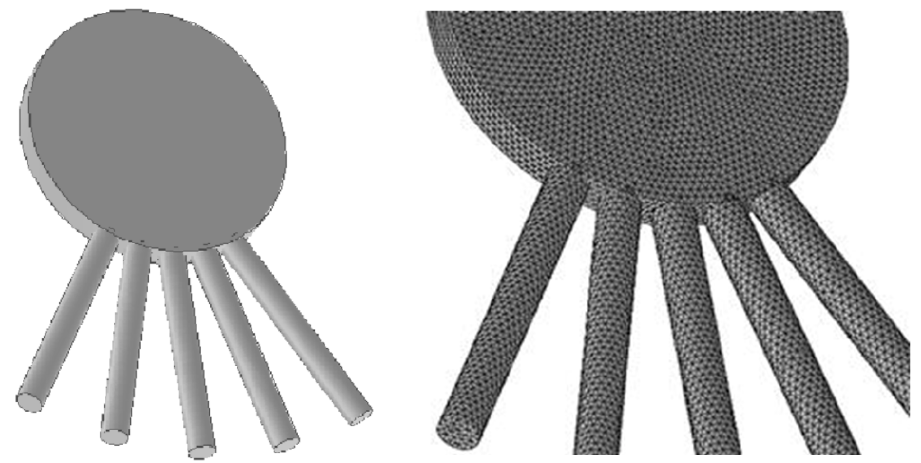
Figure 2. The geometric model of the palm and its surface network.